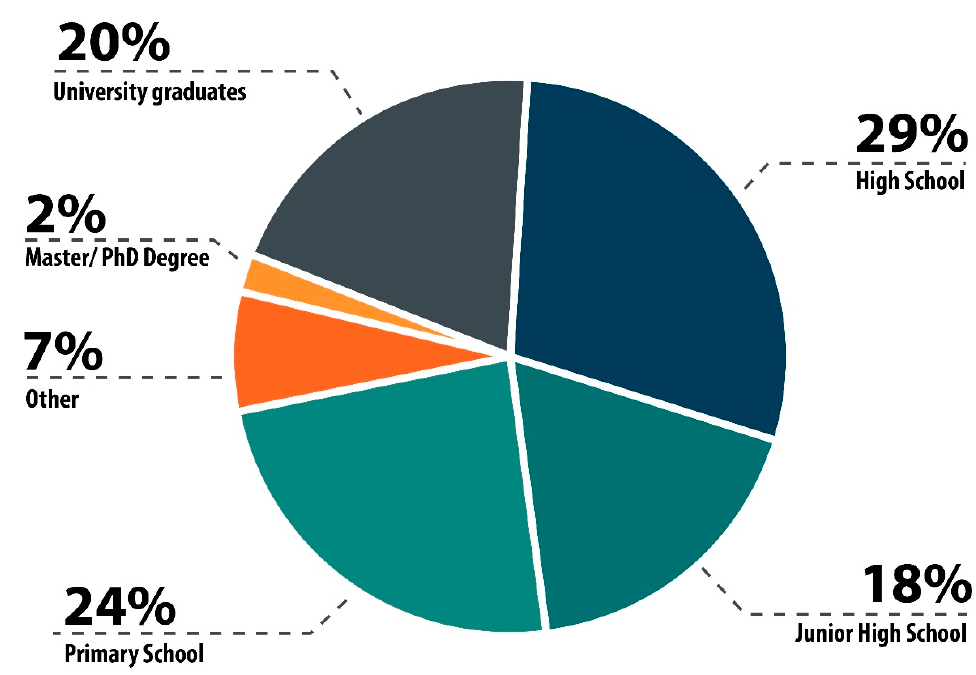
Figure 2. Education level.